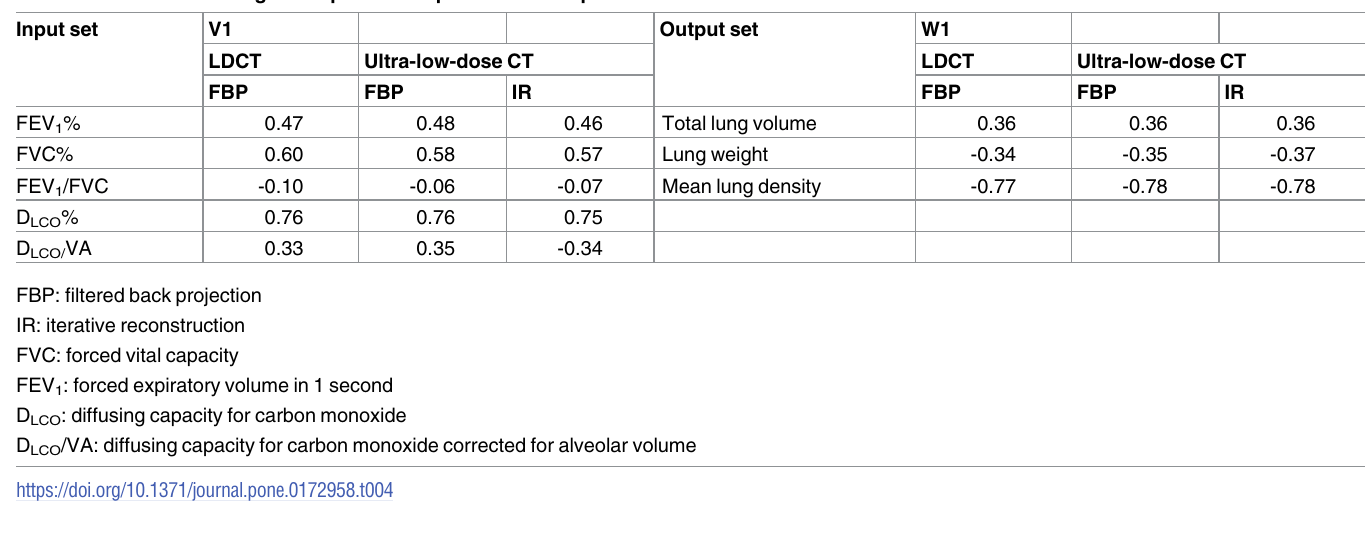
Table 4. Canonical loadings for input and output variatesfor patients with